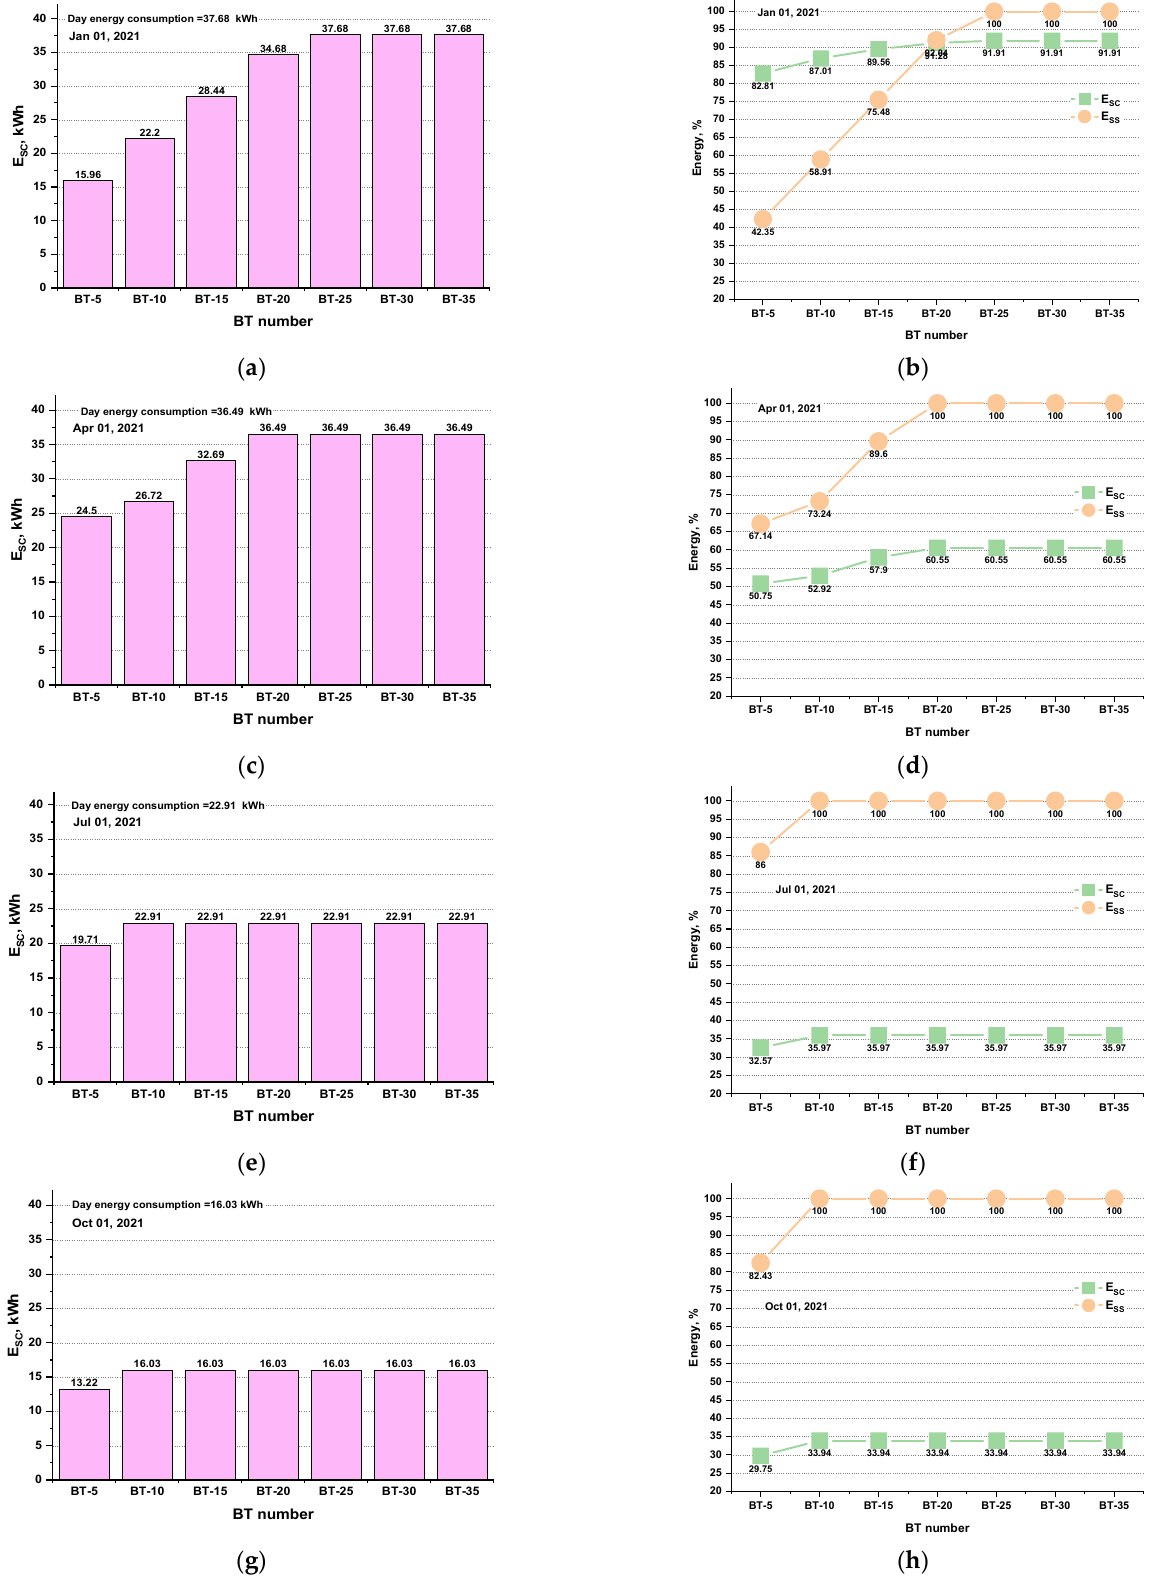
Figure 10. The E SC and E SS in kWh and percentage for four different days: ( a , b ) January 1, ( c , d ) April 1, ( e , f ) July 1, ( g , h ) December 1, at various battery bank capacities.